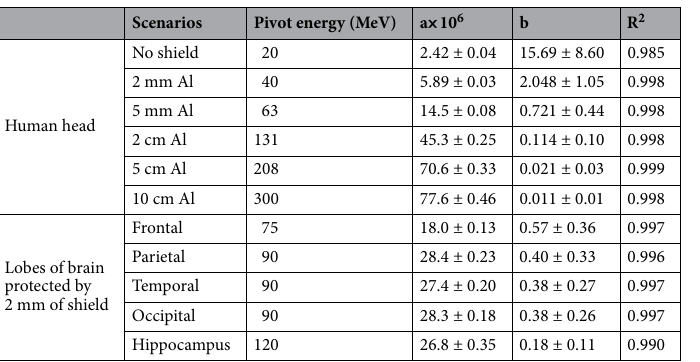
Table 2. The fitted parameters of Eq. (2) for deriving the SEP events induced dose D Brain at a certain part of the brain or the head under different thickness of Al shielding. The determined pivot energy I Pivot energy of the SEP events for different cases is also given. The fitted parameter a has the unit of cGy unit of